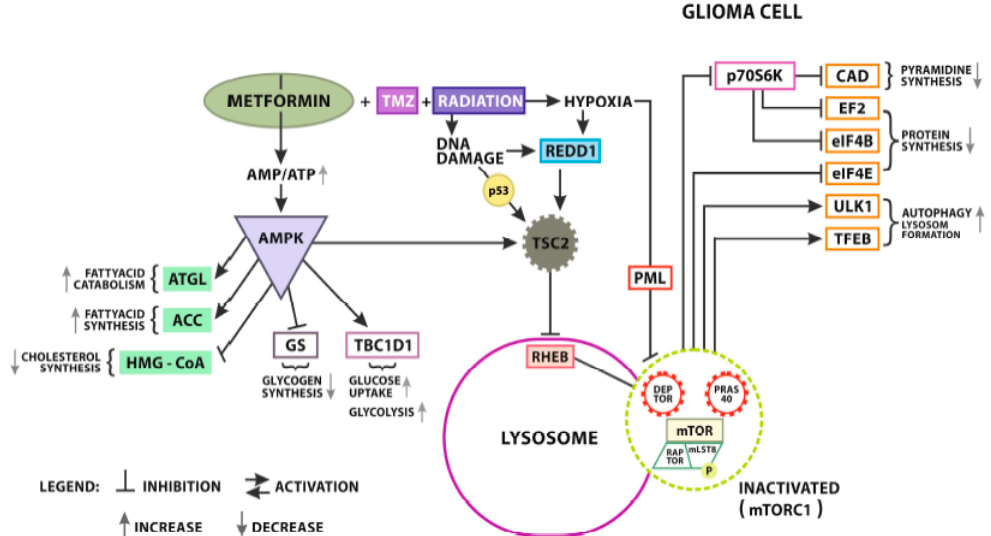
Figure 2. Metformin (MET) AMPK dependent signaling. An increase of AMP / ATP ratio activates AMPK / TSC2 signaling. TSC2 (Tuberous Sclerosis Complex 2) activation results in RHEB- mTORC 1 complex inhibition (Ras homologue enriched in the brain). Another signaling pathway causing mTORC 1 inhibition is stimulated by hypoxia and DNA damage as a result of MET + Temozolomide (TMZ) and radiation synergistic e ff ect. Hypoxia also inhibits indirectly mTORC1 by PML (promielocitic leukemia protein) activation. The right side of the scheme presents the e ff ects of mTORC1 inhibition in the glioma cell. Inactivated mTORC1 reduces p70S6K (Ribosomal protein S6 kinase) activity resulting in the decrease of CAD (trifunctional multi-domain: carbamoyl-phosphate synthetase 2, aspartate transcarbamylase, and dihydroorotase). Reduced CAD limits pirimidine synthesis in GBM cells. Collaterally, the reduction of p70S6K activity has a negative influence on EF2 (Elongation factor 2) andeIF4B (Eukaryotic translation initiation factor 4B) leading to limited protein synthesis. Contrary, the deactivation of mTORC1 promotes ULK-1(autophagy activating kinase) and TFEB (Transcription factor EB) proautophagic factors supporting new lysosomes formation. The left side of scheme presents AMPK’s direct e ff ect on lipids and glucose metabolism in GBM. Concerning lipids, AMPK promotes ATGL (Adipose triglyceride lipase) activity resulting in fatty acids’ catabolism, and regulates ACC’s (Acetyl-CoA carboxylase) activity in fatty acids synthesis. Additionally, it reduces HMG-CoA’s (HMG-CoA reductase) activity resulting in the reduction of cholesterol synthesis. As far as glucose metabolism is concerned, AMPK inhibits glycogen formation limiting GS (glycogenesis), promoting TBC1D1 (TBC1 domain family member 1) and it increases glucose uptake and glycolysis. To sum up, AMPK inhibits mTOR and improves metabolic reprogramming, which consequently suppresses tumor growth.